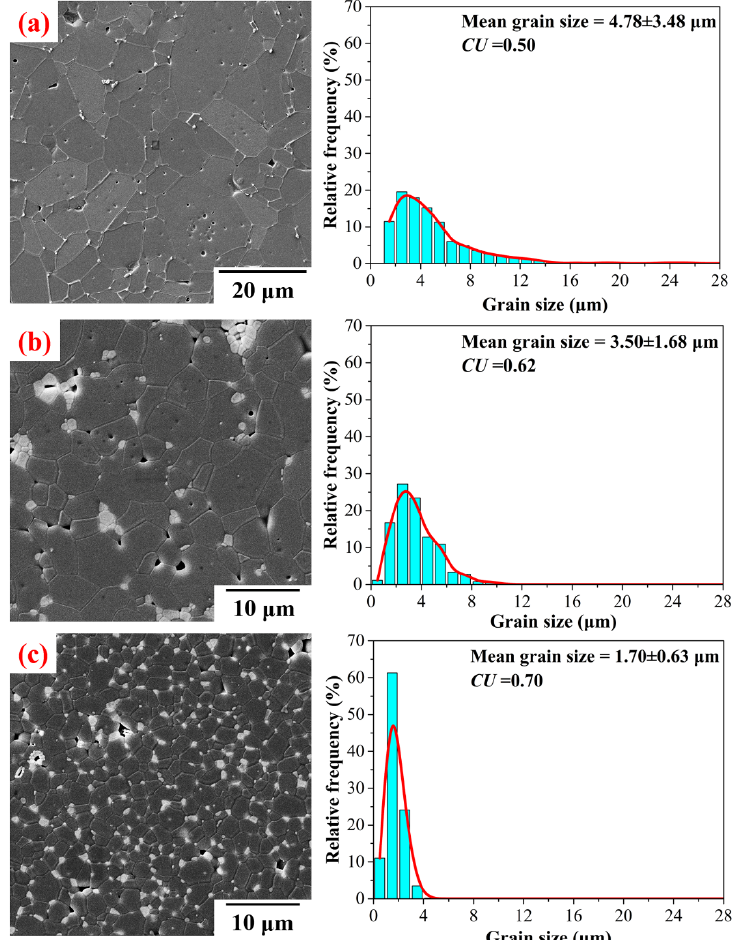
Fig. 9 Microstructures and grain size statistics of (a) Sample AL, (b) Sample MM, and (c) Sample